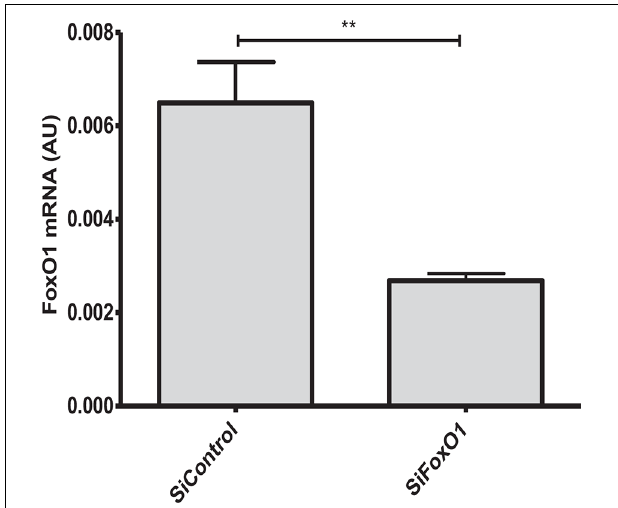
FIGURE 5 | Silencing of FoxO1 gene expression in H9C2 cells. HC92 cells were transfected with a control siRNA (siControl) or with a siRNA against Foxo1 (siFoxo1) and FoxO1 expression level was measured by qRT–PCR. Data are presented as mean ± SEM. Student’s t –test: ∗∗ P < 0.01 between two